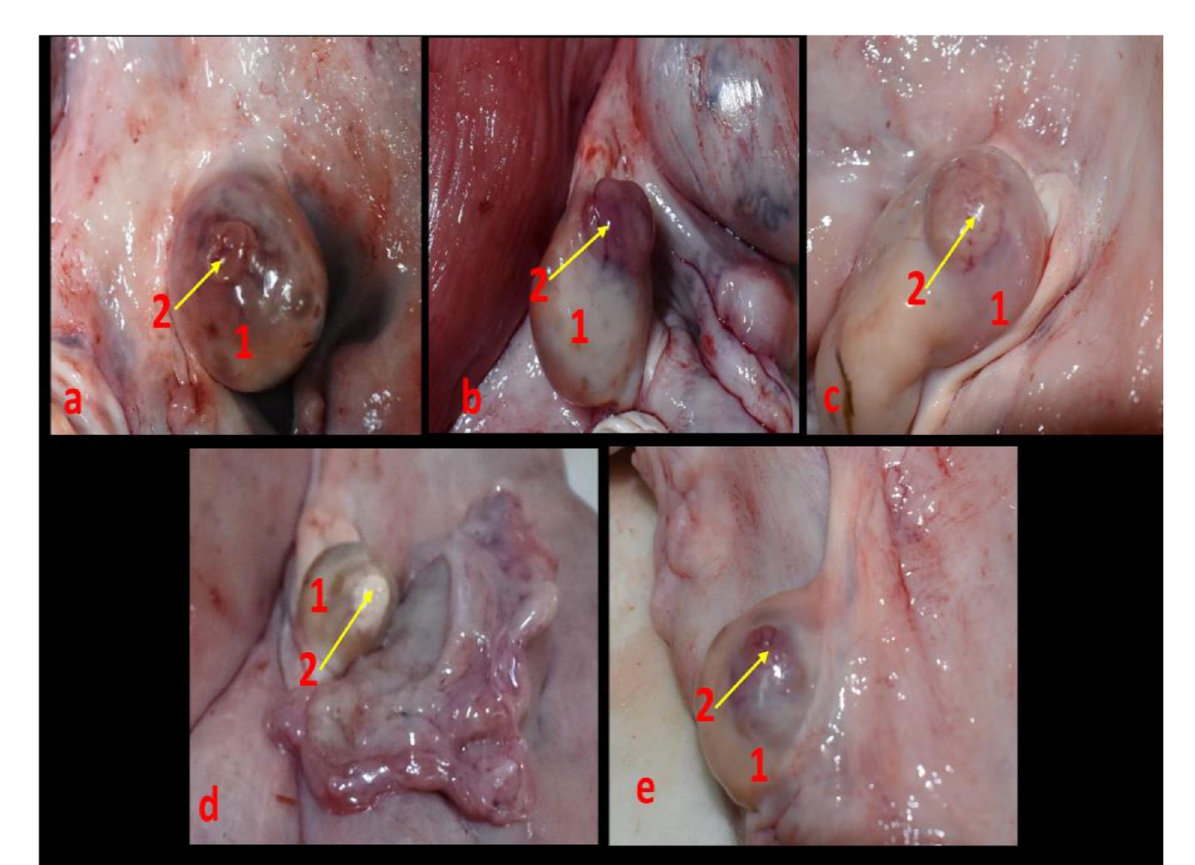
FIGURE2 Corpus luteum in the buffalo ovary at different luteal stages as (a) represented an early luteal (stage I, 1-5 days), (b) demonstrated a mid-luteal (stage II, 6-10 days), (c) showed a mid-luteal (stage III, 11–16 days), (d) showed a late luteal (stage IV, 17-20 days), and (e) demonstrated corpus luteum gravidities at early stage of pregnancy. N.B: 1, ovary and 2, corpus